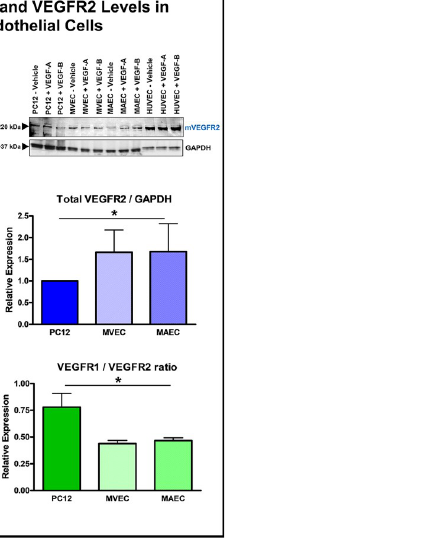
Fig 2. VEGFR1 and VEGFR2 protein expression was different in neuronal versus endothelial cells. (A and C) Representative images of immunoblots probed with anti-VEGFR1 (Panel A) or anti-VEGFR2 antibody (Panel C) showed differences in protein levels between endothelial and neuronal cells as determined by band intensity. HUVECs were used as positive controls (B and D) Fold increase in VEGFR1 (Panel B) and VEGFR2 (Panel D) expression was observed in both mouse venous (MVEC; VEGFR1-Red Striped Bar; VEGFR2-Blue Striped Bar) and aortic (MAEC; VEGFR1-Red Dotted bar; VEGFR2-Blue Dotted Bar) endothelial cells compared to PC12 neuronal cells (VEGFR1-Red Solid Bar; VEGFR2-Blue Solid Bar). GAPDH was used as a loading control; Fold change values are Mean ± SEM; n = 3; � P < 0.05 for relative VEGFR1 and VEGFR2 levels in endothelial vs neuronal cells (E) Relative VEGFR2 / VEGFR1 ratios were higher in both neuronal and endothelial cells (PC12-Violet Solid Bar; MVEC-violet striped bar; MAEC-violet dotted bar). Relative receptor ratios are Mean ± SEM; n = 3; � P < 0.05 for VEGFR2 / VEGFR1 ratio in endothelial cells vs neuronal cells (F) Relative VEGFR1 / VEGFR2 ratios were lower in both neuronal and endothelial cells (PC12-Green Solid Bar; MVEC-Green striped bar; MAEC-Green dotted bar). Relative receptor ratios are Mean ± SEM; n = 3; � P < 0.05 for VEGFR1 / VEGFR2 ratio in endothelial vs neuronal